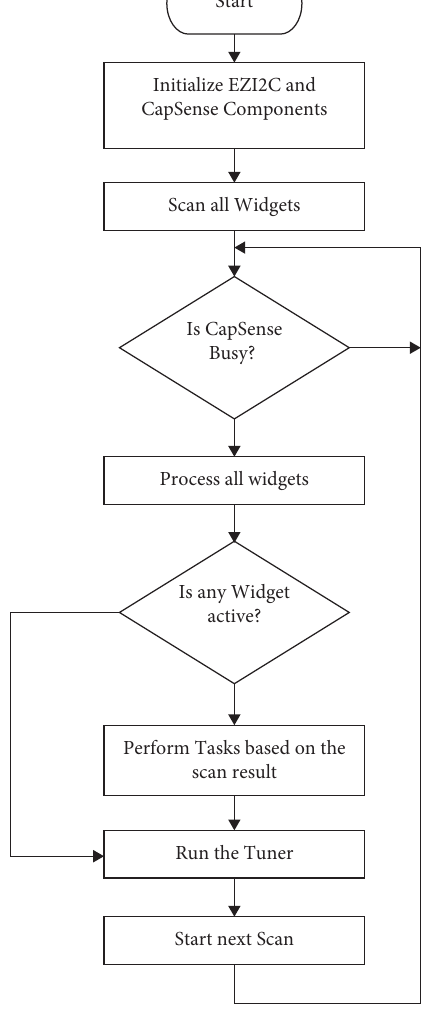
Figure 6: Firmware flowchart.